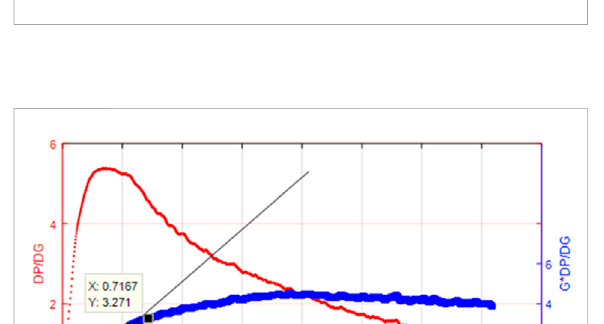
FIGURE 5 Calculation of the 1st minimum principal stress by theMuskat method.